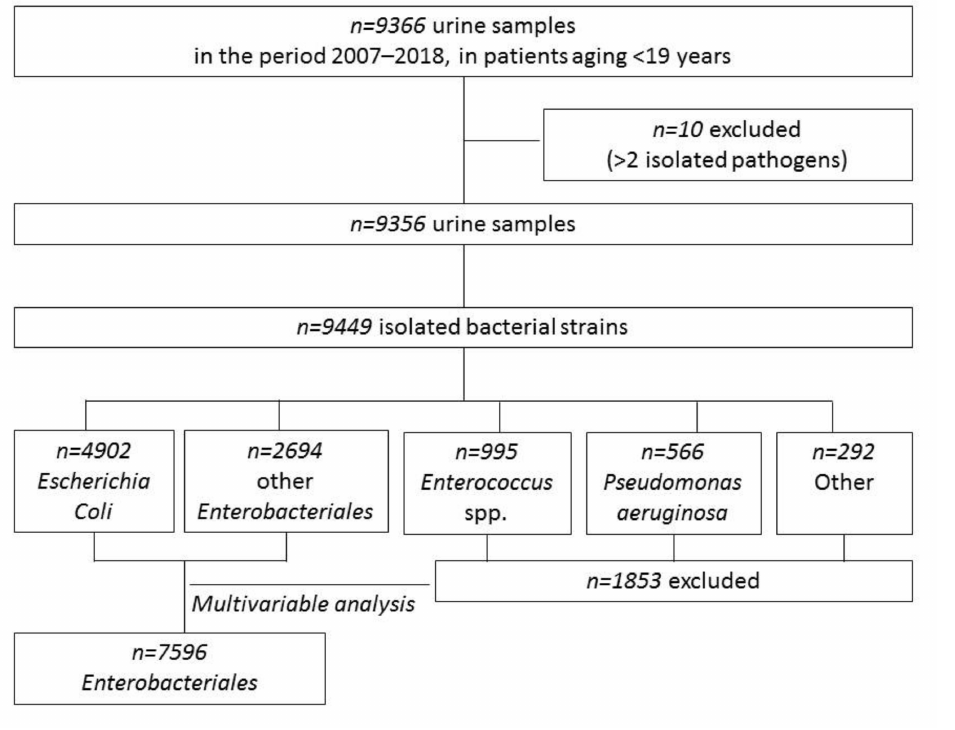
Figure 1. Flow chart of the study of urine samples and isolated